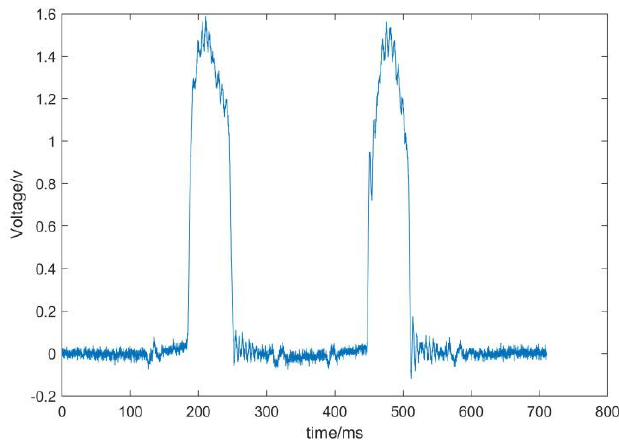
Figure 4. Weighing signal without wavelet transform.